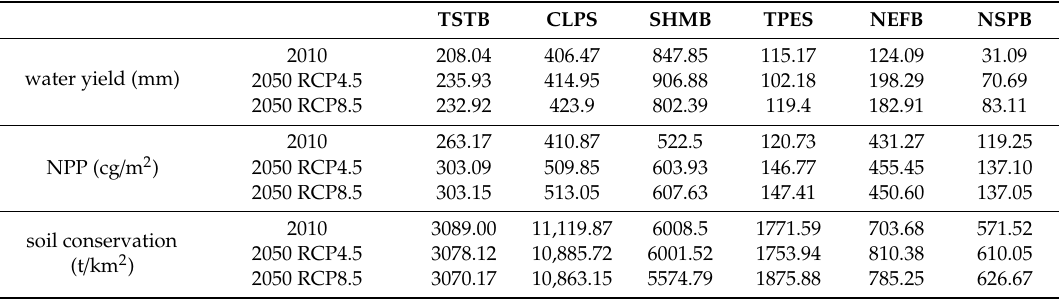
Table 2. The average water yield, net primary productivity (NPP), and soil conservation in the TSTB and each shelter in 2010 and